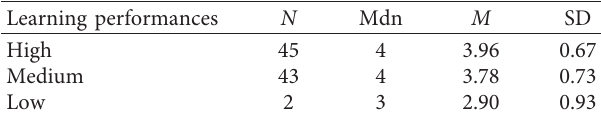
Figure 1: Box plots for total scores of attitudes in each dimension split by gender. Table 6: Independent samples t -test comparing gender differences Table 7: Analysis of variance (ANOVA) results for attitude toward in dimensions of attitude toward programming. programming among different learning